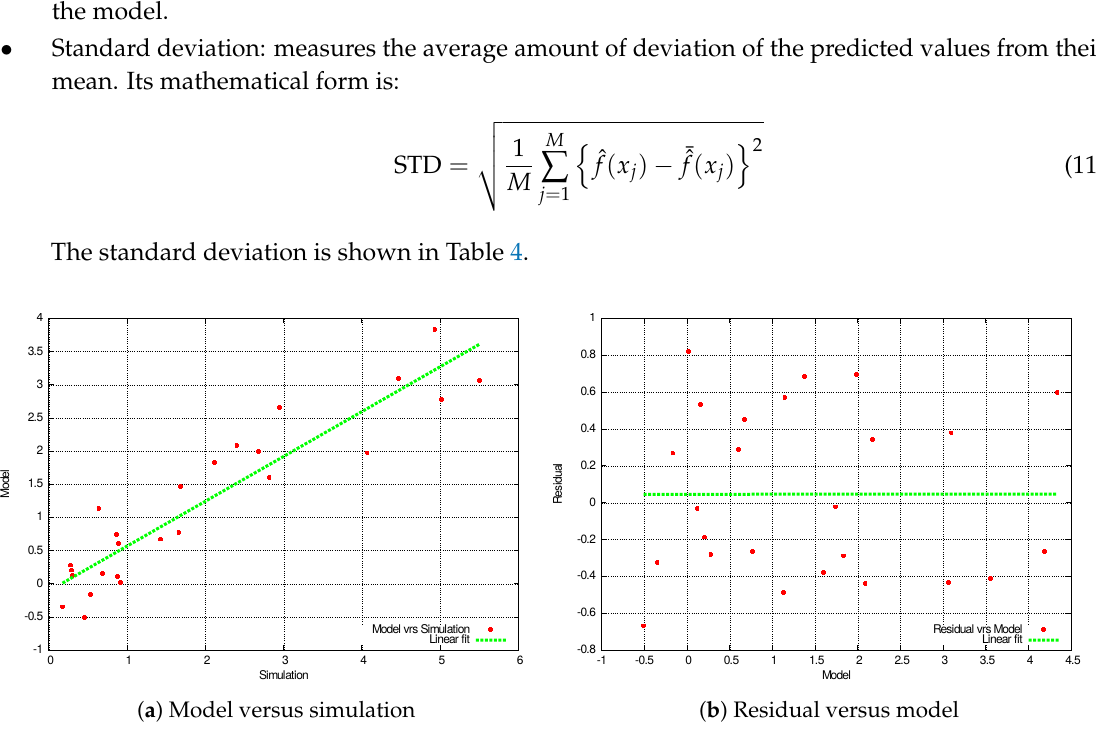
Figure 2. Plots of linear fits for model (predictor) validation: both plots measure the linear relationship between the outputs of surrogate model and the computer